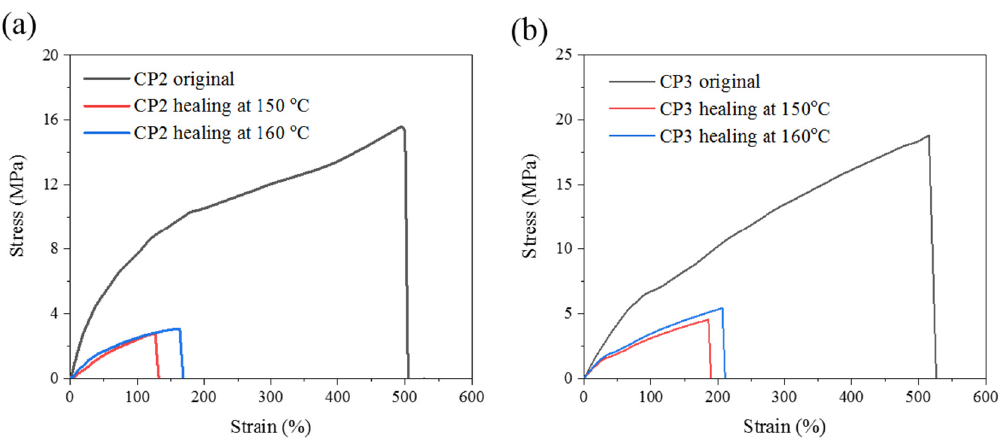
Figure 10. SEM images of copolymers before and after heating treatment: ( a ) CP1 before healing; ( b )